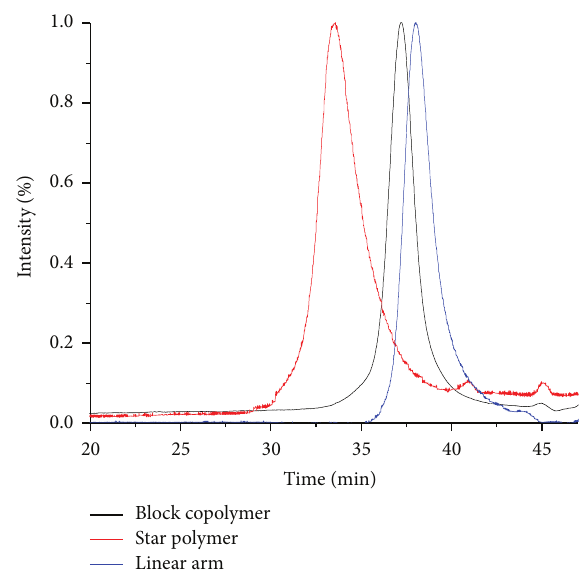
Figure 2: GPC traces of poly(NIPAAm- co -4MBA 5 )- b -polyHA(black),and[poly(NIPAAm- poly(NIPAAm- co -4MBA 5 % )- b -polyHA] 1 -EGDMA 10 (red). co -4MBA 5 % 8 ppm, respectively; other signals are superimposed and were assigned as shown in that spectrum (Figure